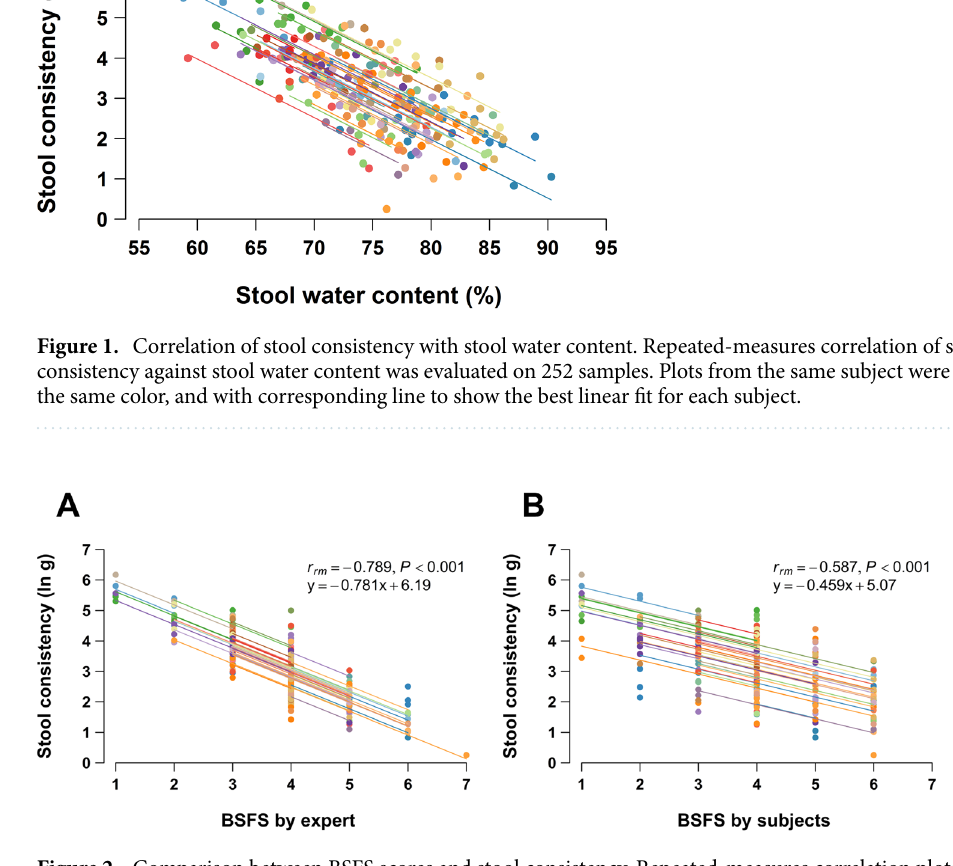
Figure 2. Comparison between BSFS scores and stool consistency. Repeated-measures correlation plots of 252 stool samples between stool consistency and BSFS score classified by ( A ) expert and ( B ) subjects. Plots from the same subject were given the same color, and with corresponding line to show the best linear fit for each